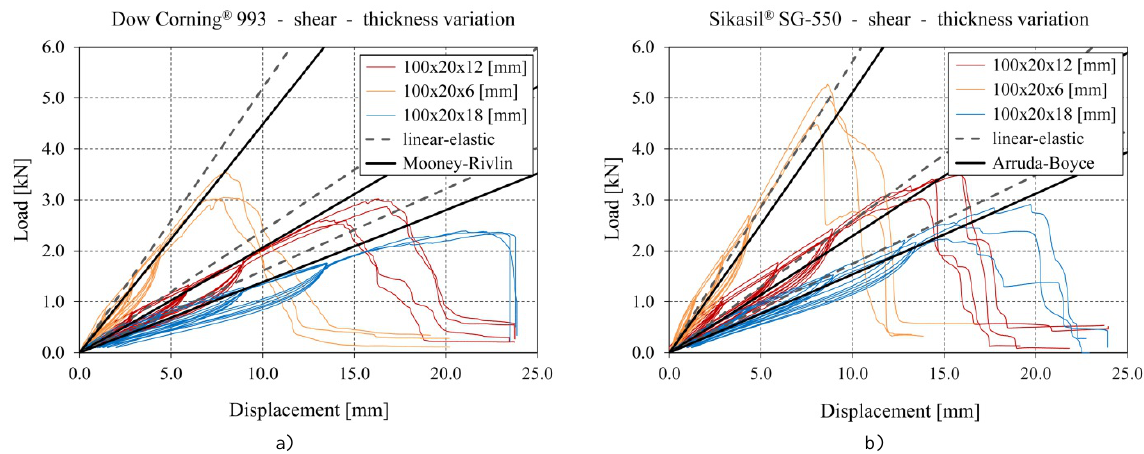
Fig. 9 Load vs. displacement results from the double-lap shear tests on linear adhesive joints with different thicknesses compared to results obtained by finite element simulations for a) joints with Dow Corning ® 993 and b) joints with Sikasil ® SG-550.